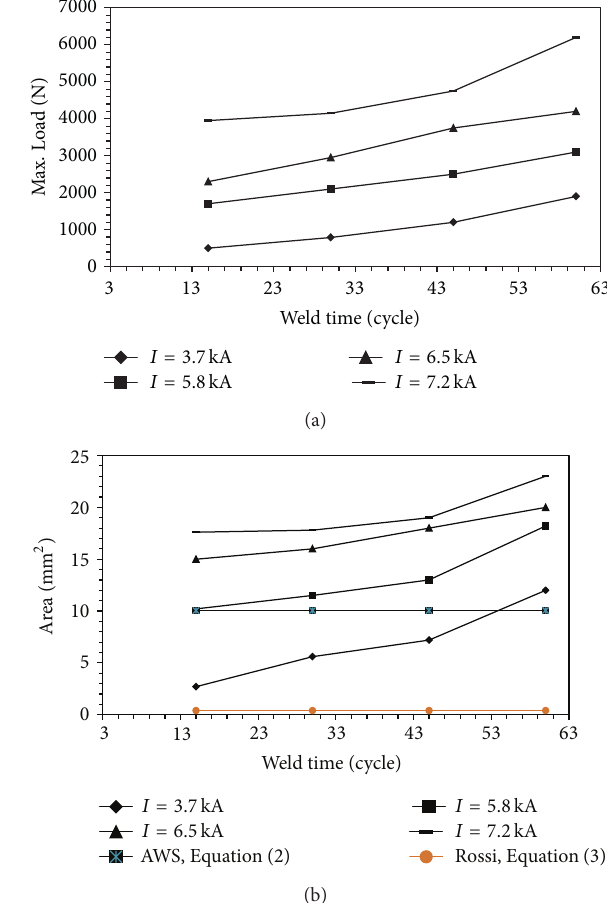
= 4mm, 𝑡 = 0.8 mm; el